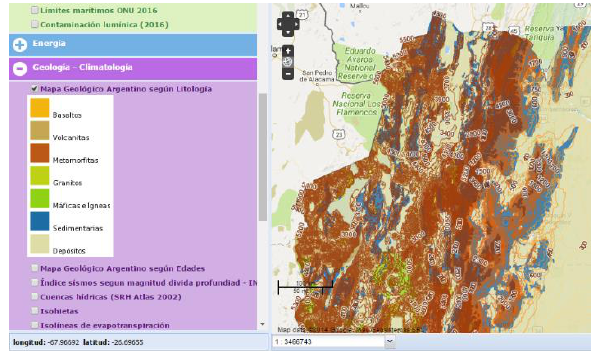
Figure 10. North-south orientation of the Andean Road System © Arches Project. Image: Screen capture, 2017 (Adapted: Multiple Locations, UNESCO, World Heritage Centre).